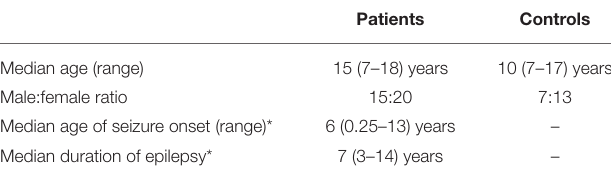
TABLE 2 | Summaries of the patient and control cohorts.